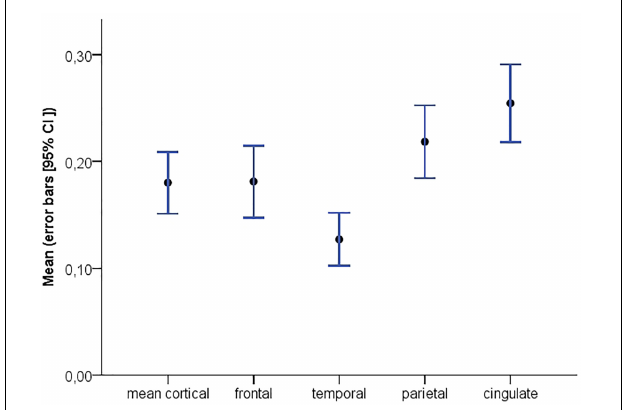
FIGURE 1 | Distribution of global and regional [ 18 F]florbetapir BP N D with corresponding 95% confidence